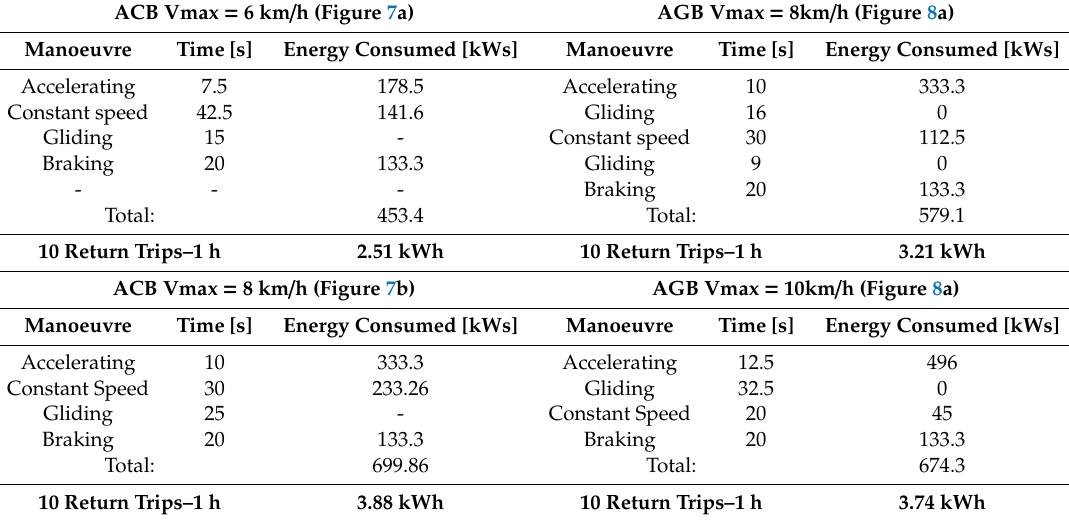
Figure 10. Profile of speed and power demand in the first stage of the cruise using the AC strategy when the ferry covers 52 m. Table 1. Comparison of the actual energy demand of a ferry moving in accordance with the adopted ACB and AGB strategies for one hour, making ten return